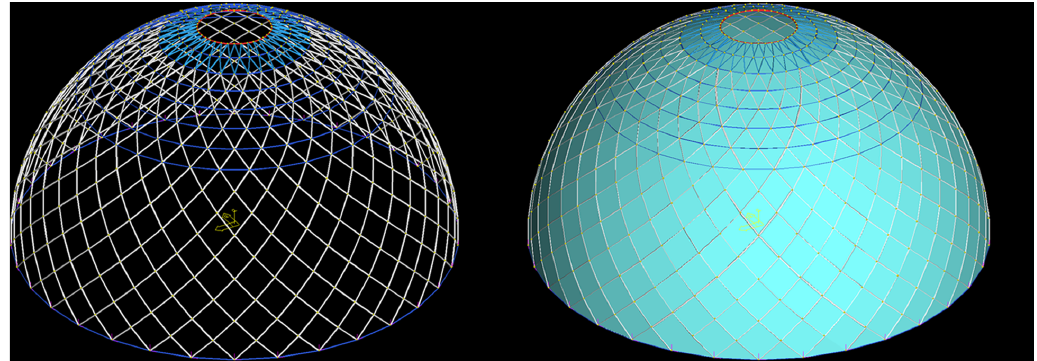
Figure 11: The lattice dome. Left: truss elements with upper compression rings and lower tension ring. Right: the same with membrane